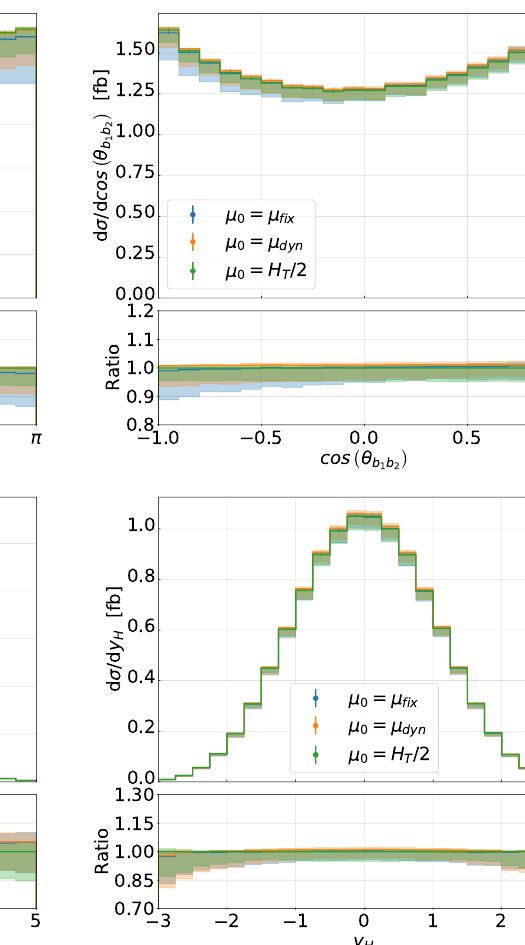
Figure 7 . Differential distributions at NLO QCD for the observables ∆ φ and y H for the pp → e + ν e µ − ¯ ν µ b ¯ b H process at the LHC with µ 0 = µ fix , µ 0 = µ dyn and µ 0 = H T / 2 . The NNPDF3.1 PDF set is employed. The upper panels show absolute predictions together with corresponding uncertainty bands resulting from scale